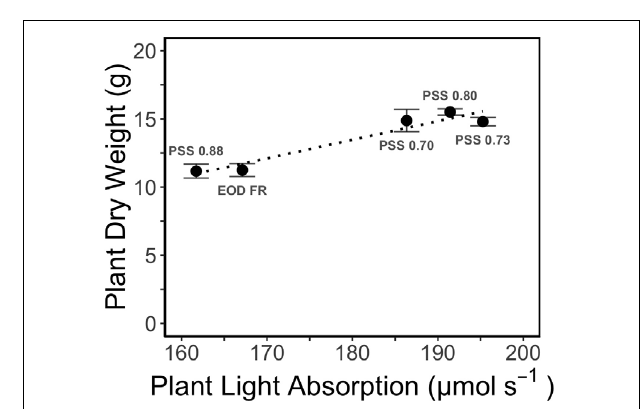
FIGURE 7 | Relation between simulated whole plant light absorption and measured dry weight (DW) of tomato plants grown for 4 weeks under different light treatments in EXP1. The dotted line represents linear regression ( r 2 = 0.93, P < 0.01). Error bars represent SEM ( n = 3).